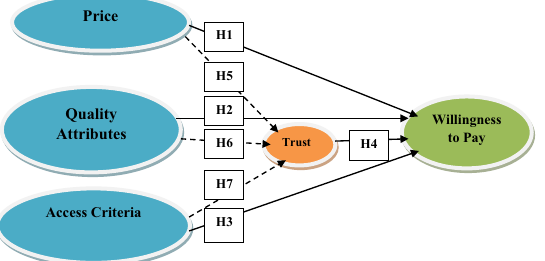
Fig. 1 Conceptual framework of this